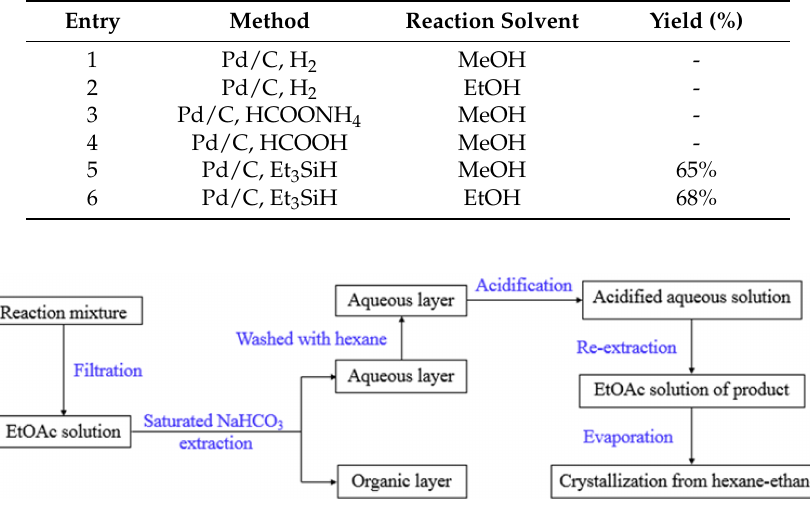
Figure 2. Schematic representation of the isolation of 5 from the reaction